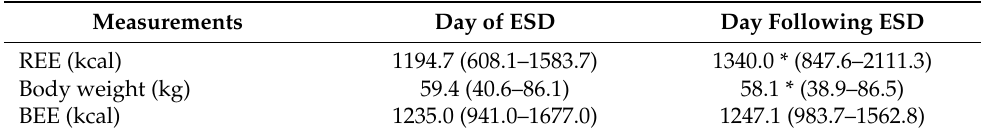
Table 2. Changes in REE, body weight, and BEE.